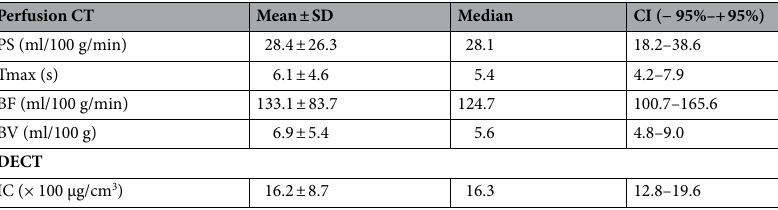
Table 3. Quantitative parameters from perfusion computed tomography and dual-energy computed tomography. BF blood flow, BV blood volume, PS permeability surface area product, Tmax the time-to- maximum of the tissue residue function, SD standard deviation, CI confidence interval.